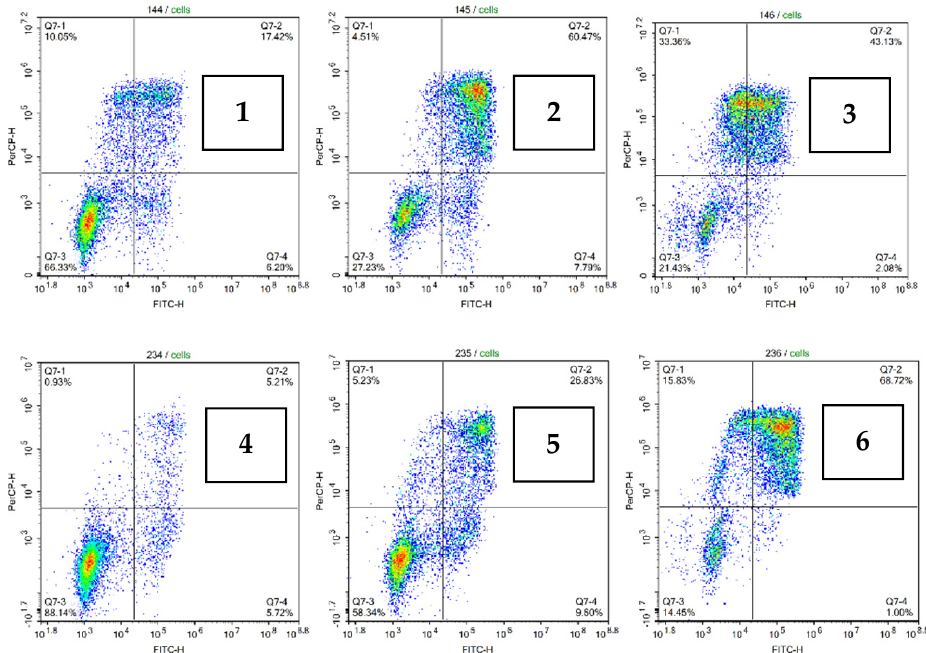
Figure 1. The Jurkat tumor cell line treated with various concentrations of compounds 24b and 24c . Cells were stained with annexin V/7-AAD and analyzed using flow cytometry. ( 1 ) 24c (0.02 µ М ); ( 2 ) 24c (0.05 µ М ); ( 3 ) 24c (0.1 µ М ); ( 4 ) 24d (0.02 µ М ); ( 5 ) 24d (0.05 µ М ); ( 6 ) 24d (0.1 µ М ). PerCP: Peridinin chlorophyll A protein; FITC: Fluorescein isothiocyanate.